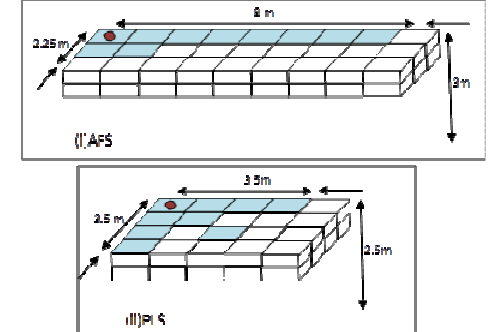
Fig. 1. The upper layer voxels and cellules (1.0 m x 1.0 m x (0.5 m+0.5 m) in one quarter of root growing volume in (i) AFS and (ii) FRS (PLS). Blue boxes are root harvested cellules and brown ellipse is the stump